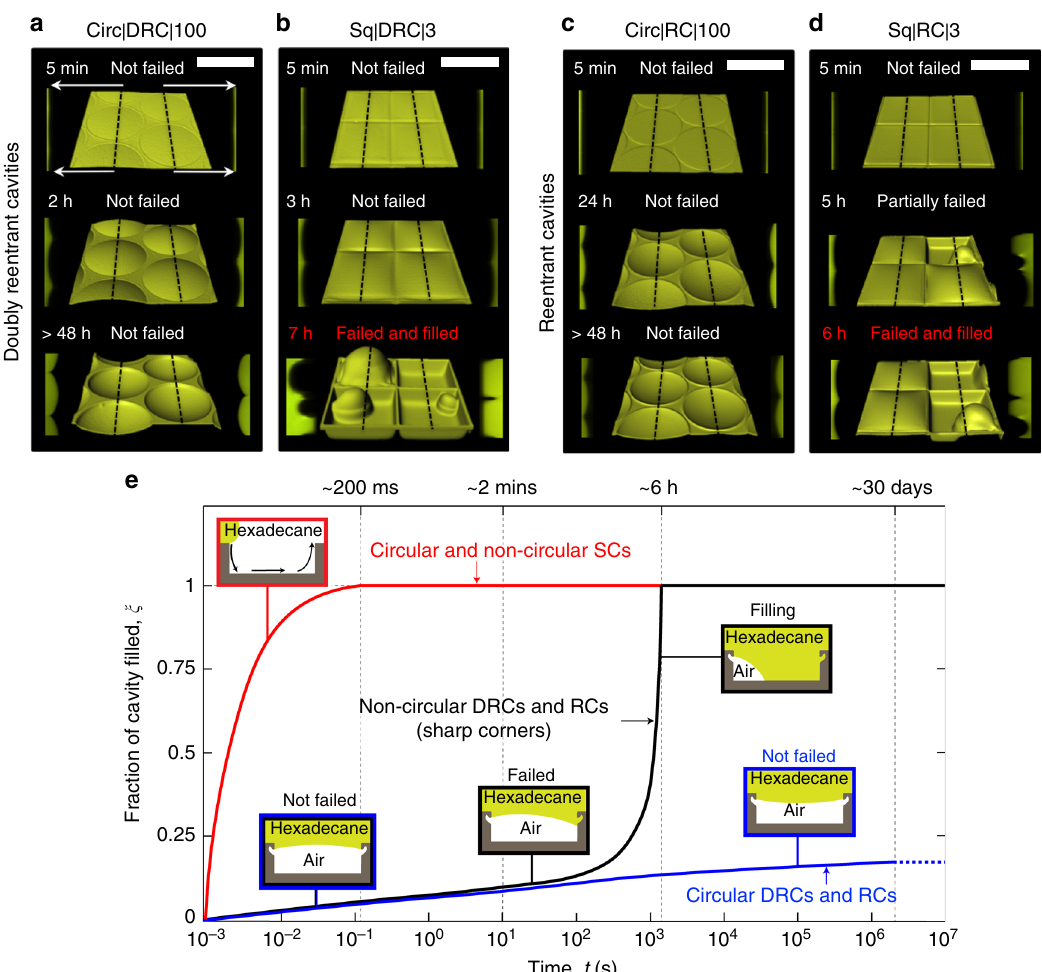
Fig. 3 Silica surfaces with reentrant and doubly reentrant cavities immersed in hexadecane. a – d Computer-enhanced isometric reconstructions of the hexadecane-air interface (center) along with the cross-sectional views along the black dotted lines (on left and right sides of the central image) as a function of time. a , c Intruding hexadecane menisci were robustly stabilized at the edges of circular DRCs and RCs (Supplementary Figure 8). b , d In contrast, DRCs and RCs with square shape failed at the corners much faster leading to the loss of trapped air. The stability of the liquid meniscus resting on the edges of the DRCs and RCs was lower if the corners were sharp (Supplementary Figure 7). e A semi-quantitative plot demonstrates the ef fi cacy of circular DRCs and RCs in sustaining trapped air for > 3 orders of magnitude longer than square DRCs and RCs, and >7 orders of magnitude longer than commensurate SCs. (Scale bars: 200 µ